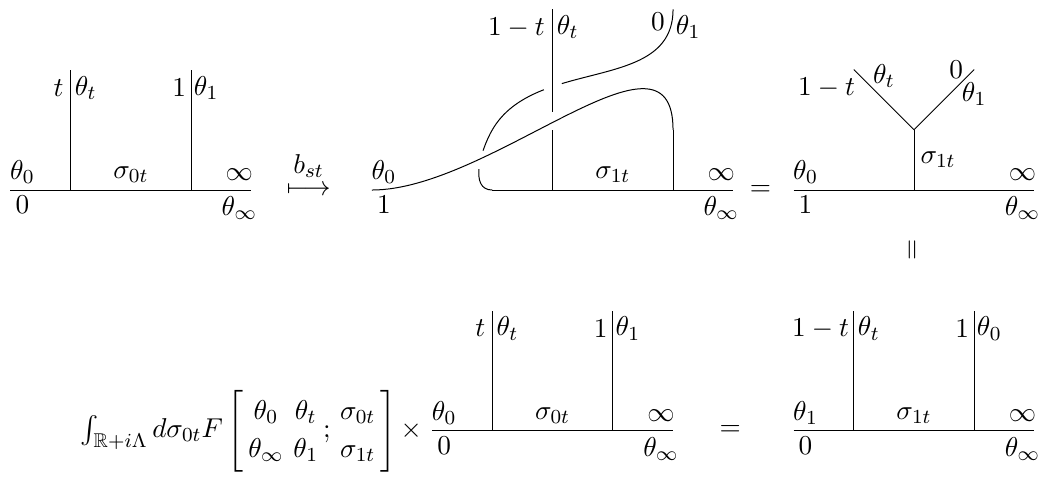
Figure 4 . Fusion transformation as the action of the braid